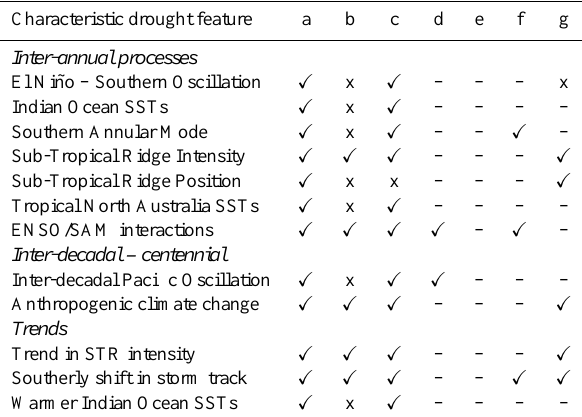
Table 2. Identifies the characteristics of the Big Dry that are consis- tent with the typical influences of known climate processes. These include similarities in spatial and temporal features and associated small-scale influences e.g., the influence of an inter-annual process on weather systems. The seven major defining characteristics of the drought identified in Sect. 5 are stated below the table. A tick indi- cates that a characteristic feature of the drought is consistent with current understanding of how the processes in the far-left column influence the regional climate, a cross indicates an inconsistency and a dash indicates that the link between that characteristic and the climate process is